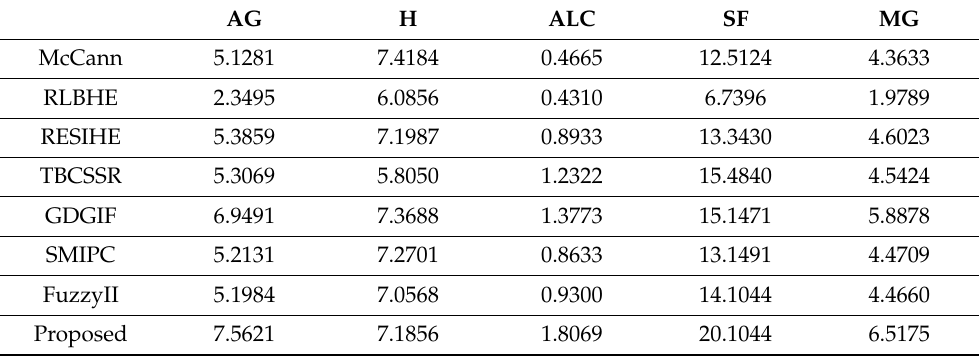
Table 2. The metric data of eight methods on X-ray image